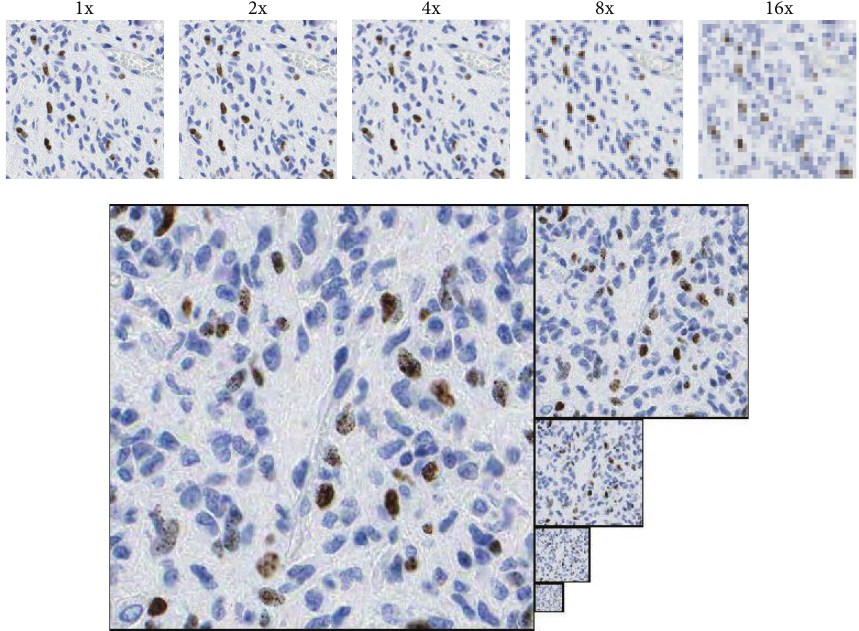
Figure 1: Fragments of WSI in original and decreased resolution: 2x, 4x, 8x, and